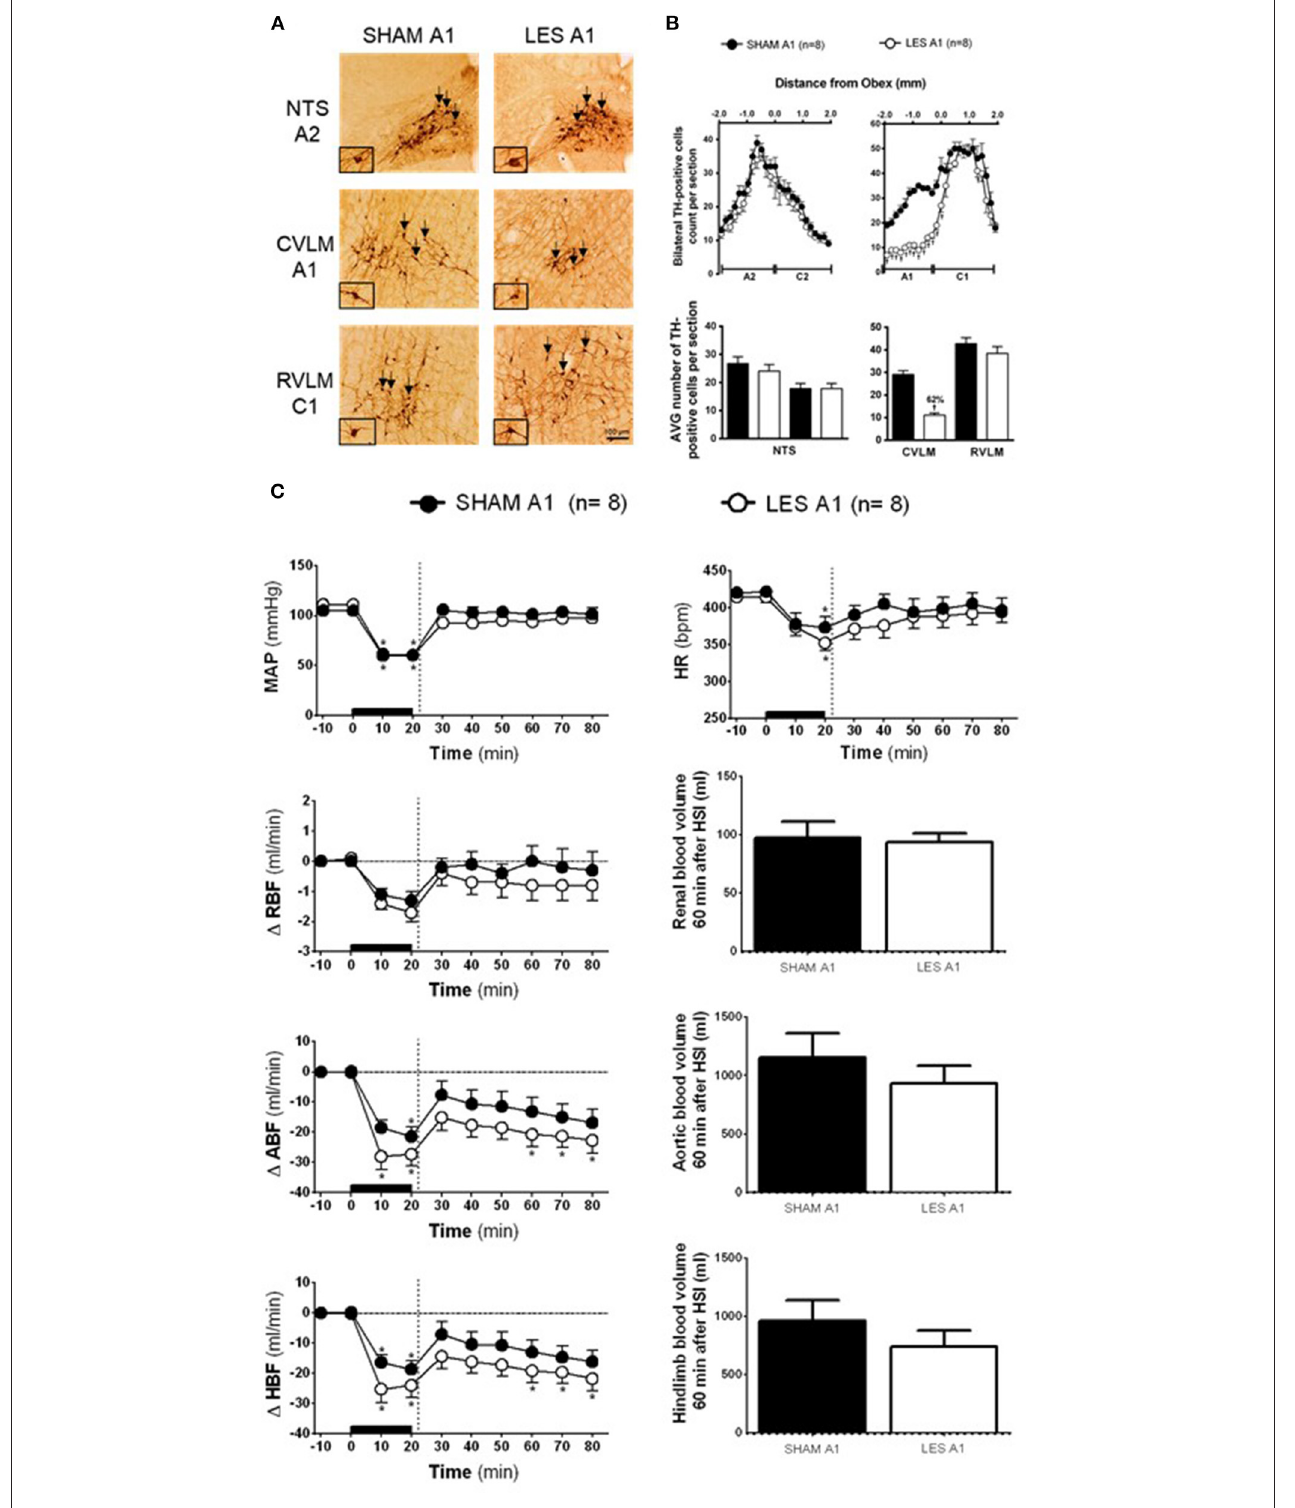
FIGURE 1 | (A ) A representative photomicrograph of medullary coronal sections (40 µ m) with the scale bar of 100 µ m. The arrows indicate positive tyrosine hydroxylase neurons in the nucleus of the solitary tract (NTS—cluster A2), caudal ventrolateral medulla (CVLM—cluster A1), and rostral ventrolateral medulla region (RVLM—cluster C1) of the animals bilaterally nanoinjected with saporin (SHAM A1 group) or saporin-anti-D β H (LES A1) in CVLM. (B) Quantification of tyrosine